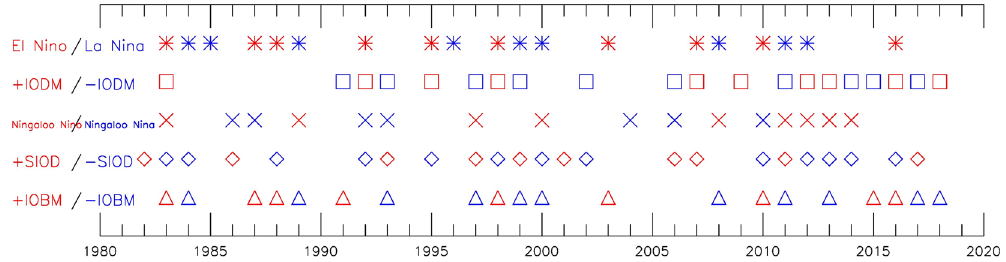
Figure 2. The positive (red) and negative (blue) phase events identified from their respective index during 1982–2018. For convenience of comparison, ENSO (IODM) events are labeled as the decaying (second) year.